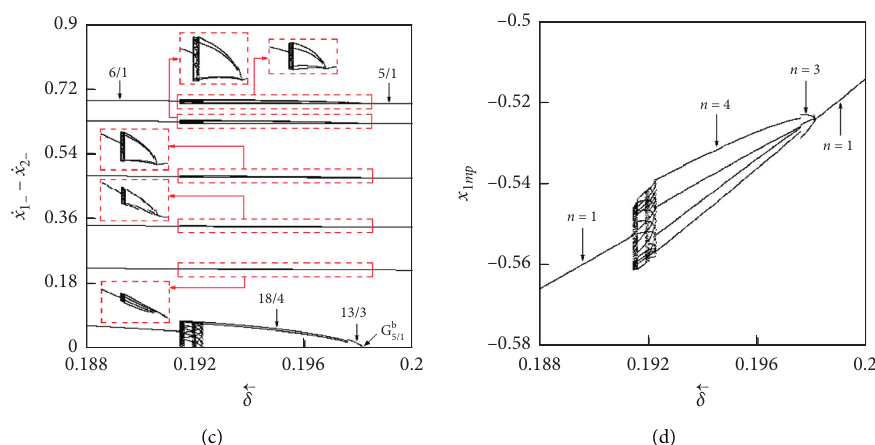
Figure 13: Bifurcation diagrams that cross the tongue-like region TR diagram; (b) periodic bifurcation diagram; (c) local enlargement of Figure 13(a); (d) local enlargement of Figure 13(b).